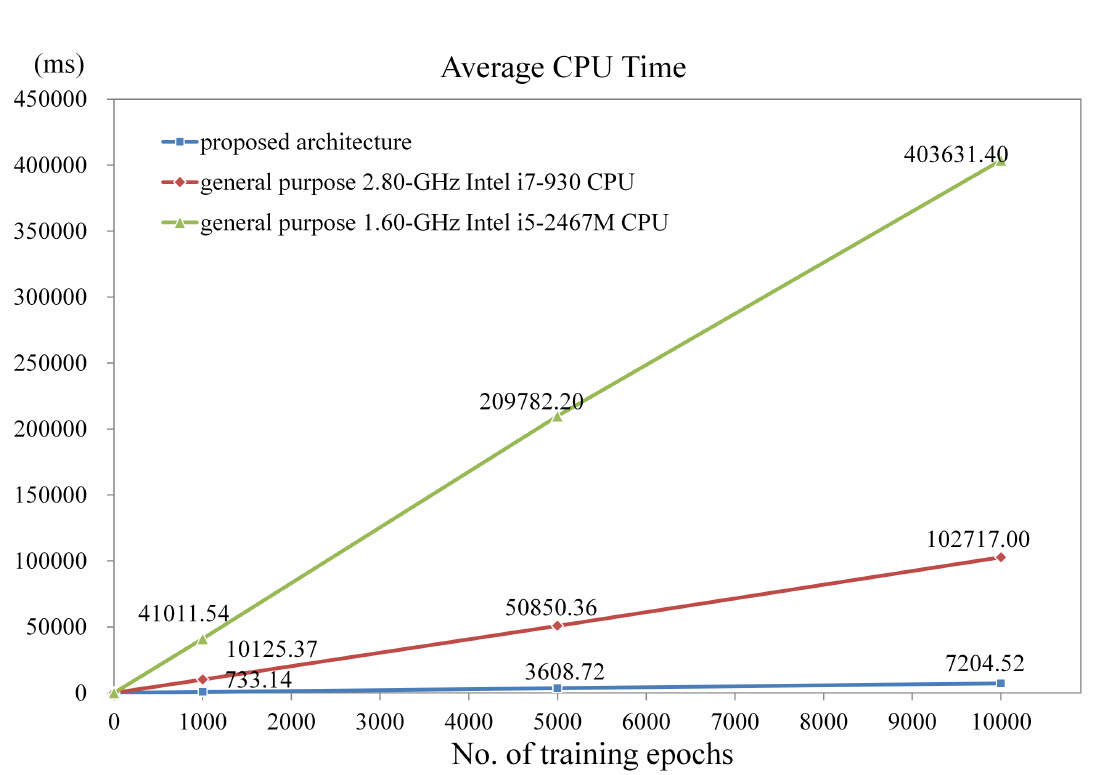
Figure 23. The CPU time of the NIOS-based SOPC system using the proposed architecture as the hardware accelerator for various numbers of training iterations with m = 16 × 16 and p = 7